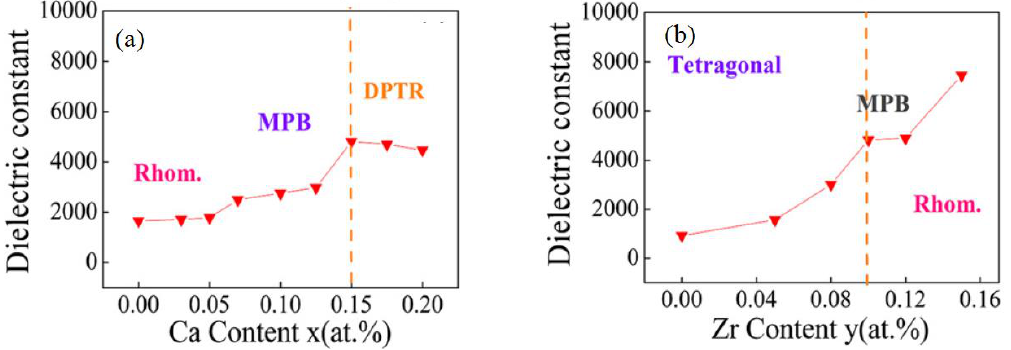
Figure 6. ( a ) The dielectric constant ( ε r ) of (Ba 1_x Ca x )(Zr 0.1 Ti 0.9 )O 3 ceramics. ( b ) The dielectric constant (ε r ) of (Ba 0.85 Ca 0.15 )(Zr y Ti 1_y )O 3 ceramics. For different acronyms in the figures, please see the text. Reprinted with permission from [57]. Copyright 2012 The American Ceramic Society.